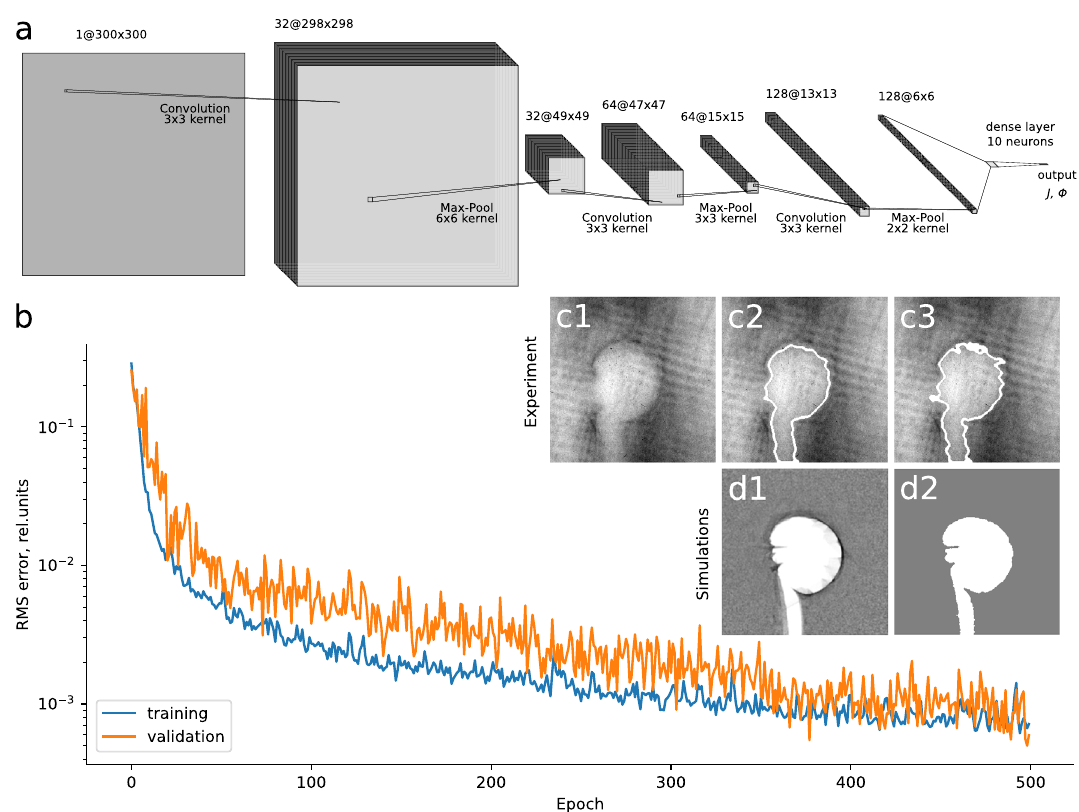
Figure 3. Architecture of the developed CNN ( a ) and learning curves for training and validation data sets, obtained in training run #1 and displaying the decrease of the mean squared error with the number of epoch ( b ). Panels ( c1 ) and ( d1 ) provide a comparison of proton patterns obtained in the experiment and in simulation for the field parameters extracted in training run #1. Corresponding ’void’ contours used for assessment of the fields are shown in panels ( c2 , c3 , d2 ); for the experimental image two different possible contours are shown, ( c2 ) corresponds to the parameters of the contour retrieval algorithm that intuitively provide a better fit of the ’void’ region boundary while ( c3 ) corresponds to the parameters which match those that were used to retrieve the contours from all synthetic images. For easier comparison experimental contours are shown without inner fill and are imposed on the original experimental